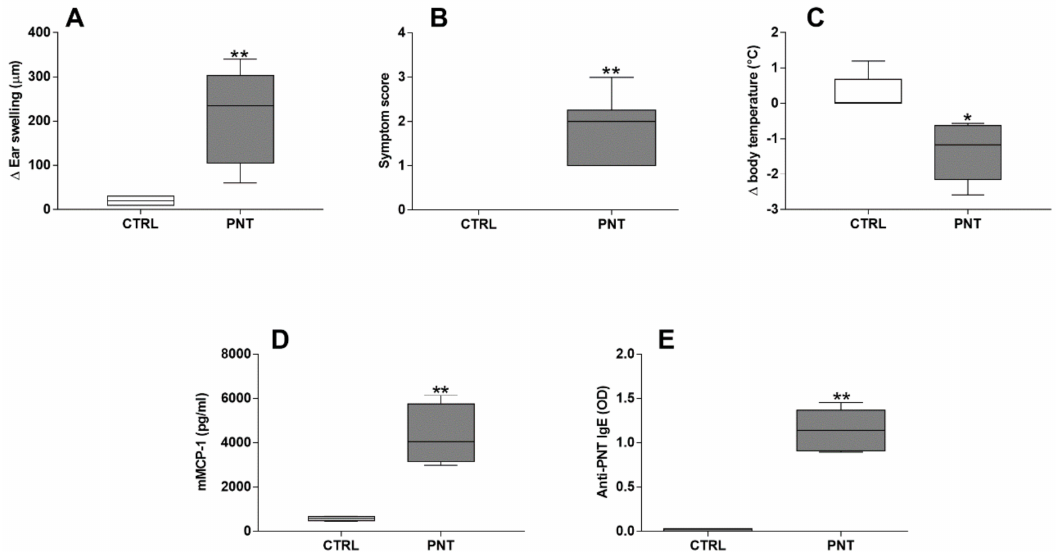
Figure 2. Proofs of effective sensitization to PNT. Acute allergic ear swelling response 1 h after intradermal injection of PNT in the ear pinnae ( A ), anaphylactic symptoms score ( B ), body temperature decrease ( C ), serum levels of mMCP-1 ( D ) and anti-peanut IgE ( E ). Data were analyzed with independent sample t -test. CTRL = control mice; PNT = mice sensitized with peanut extract. * vs. CTRL, p < 0.05; ** vs. CTRL, p < 0.0001. Data represent pooled values from two separate experiments.